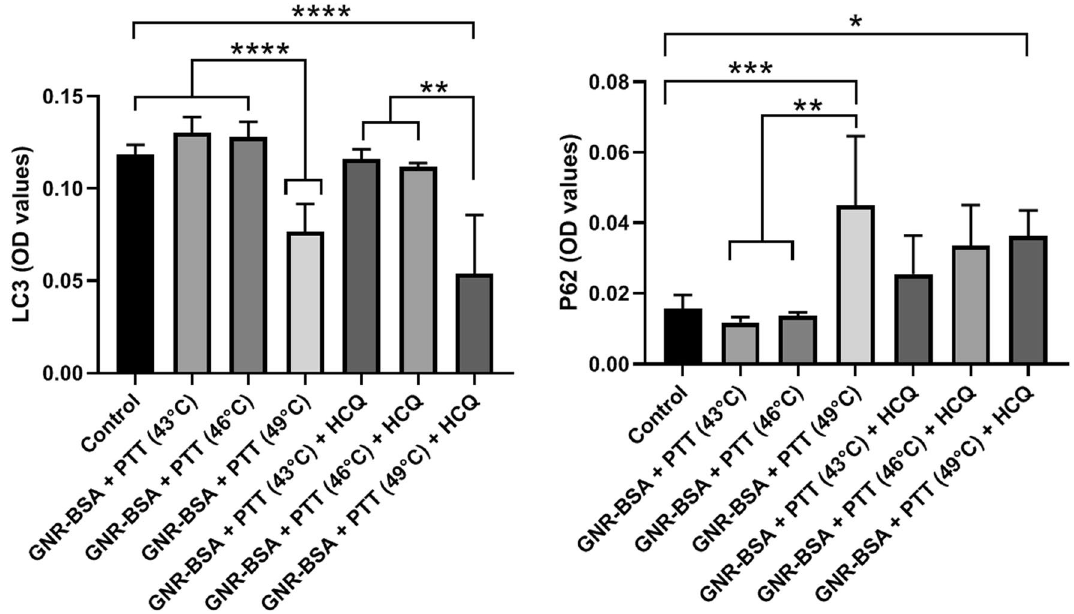
Figure 5. Measuring protein levels of P62 and LC3 using ELISA. Data showed the efficiency of PTT and PTT + HCQ in the alteration of both proteins related to the autophagy signaling pathway. One-Way ANOVA and Tukey post hoc analysis. * p < 0.05; ** p < 0.01; *** p < 0.001 and **** p < 0.0001.